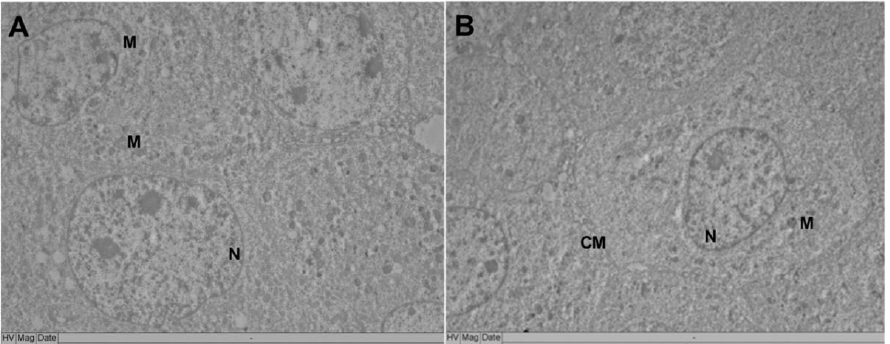
Figure 10. Morphological aspects of L929 cells were assessed by Giemsa staining, after 24 h of treatment. ( A ) Negative control; ( B ) Vector control (hydrogel without extract) at higher concentration; ( C ) VADE-loaded-hydrogel at 500 µg/mL; ( D ) VADE-loaded-hydrogel at 1000 µg/mL. Scale bars = 50 µm.